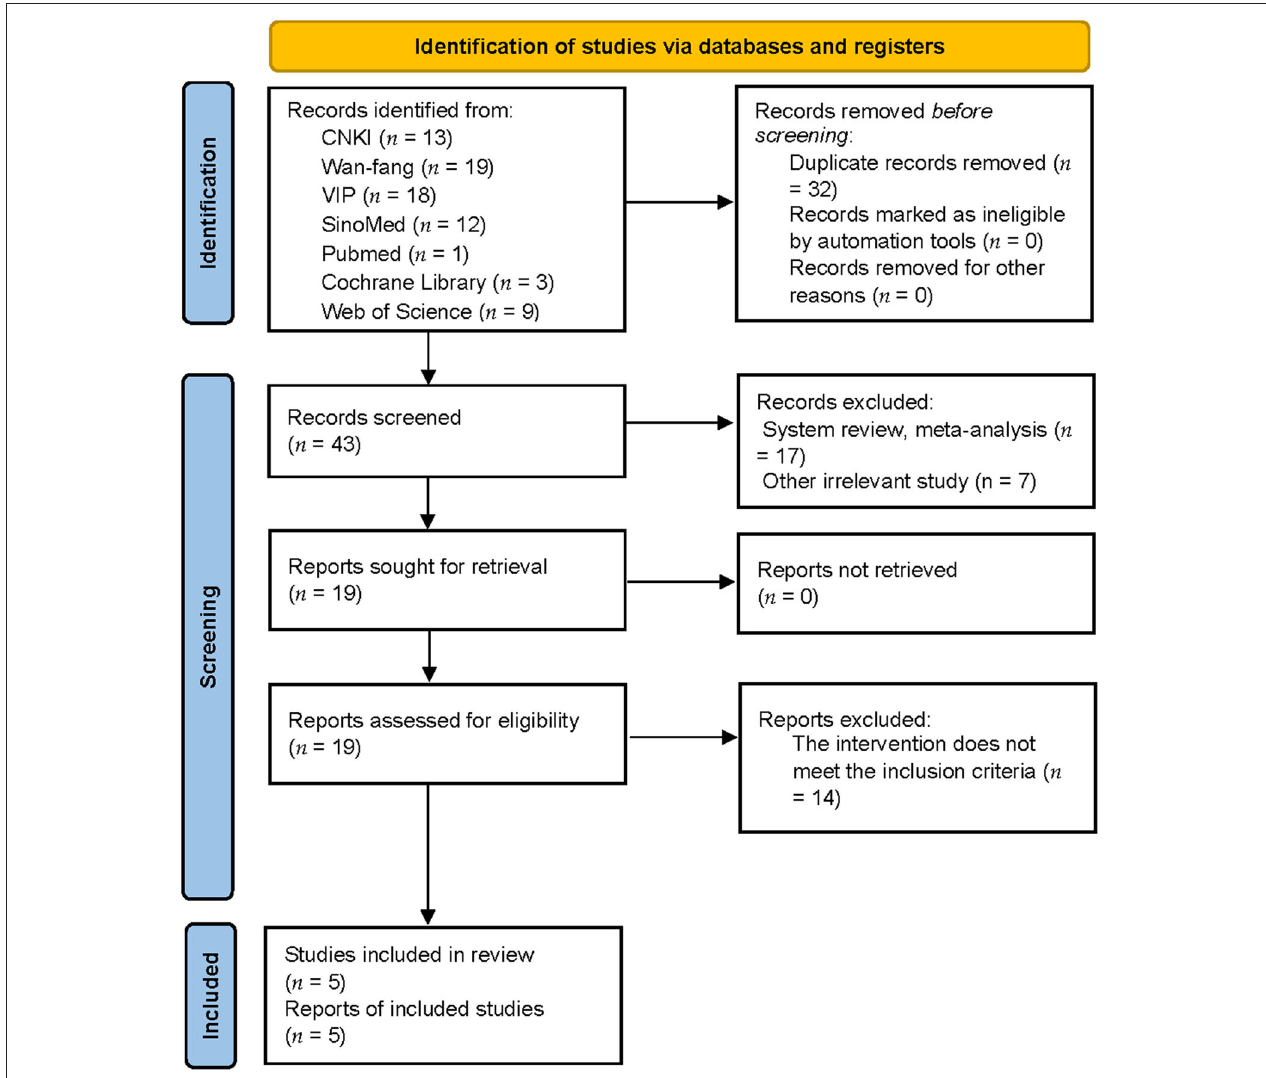
FIGURE 1 | Flow diagram depicting the study selection process (n, number of publications).